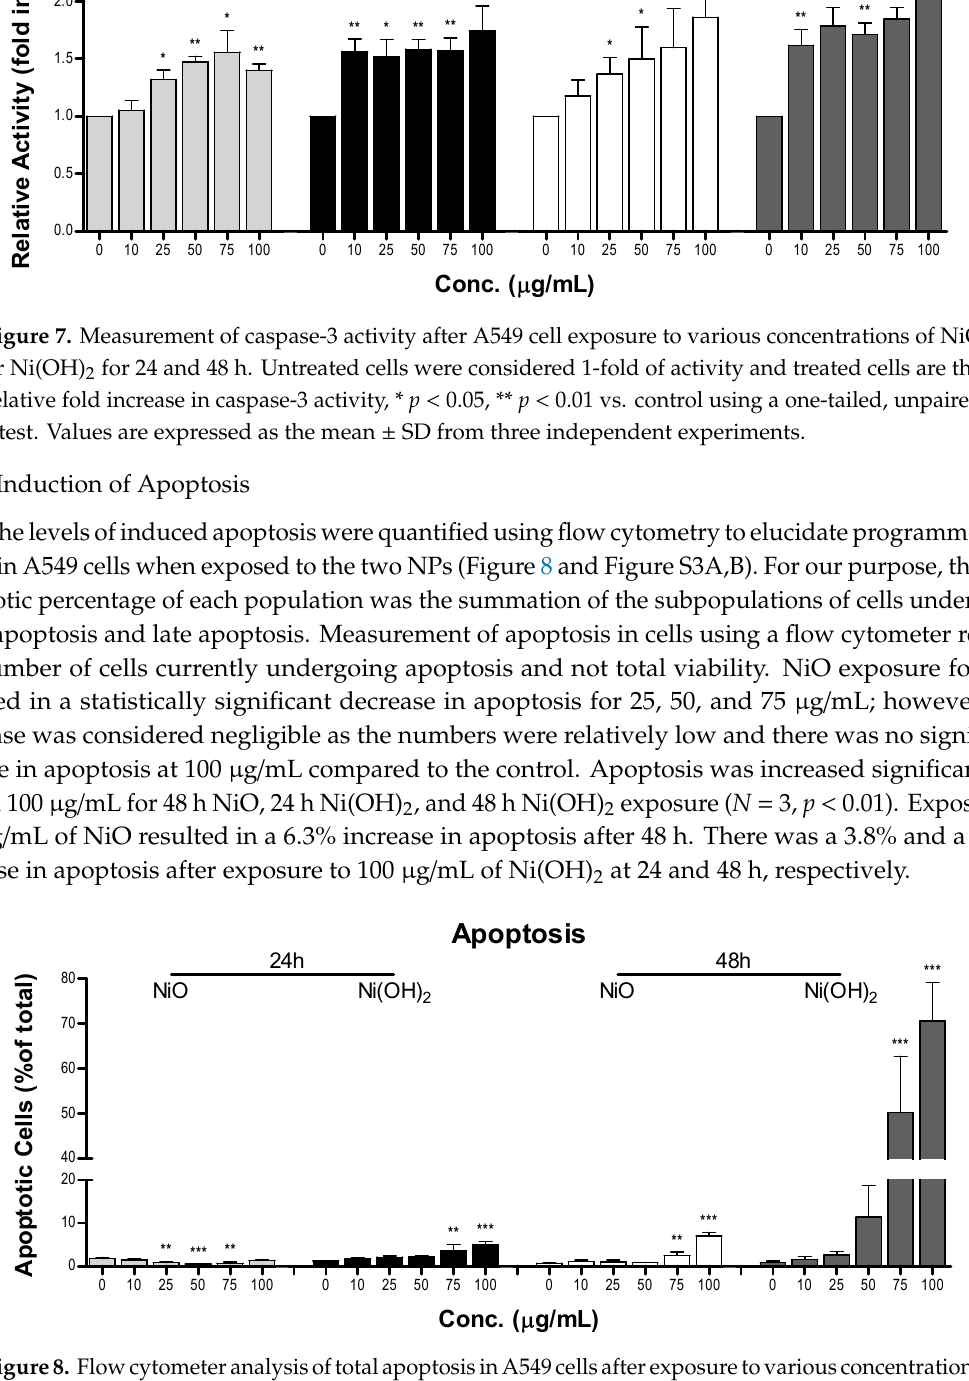
Figure 8. Flow cytometer analysis of total apoptosis in A549 cells after exposure to various concentrations of NiO or Ni(OH) 2 for 24 and 48 h, ** p < 0.01, *** p < 0.001 compared to each respective control using a one-way ANOVA with a Dunnett comparison. Values are expressed as the mean ± SD from three independent experiments.